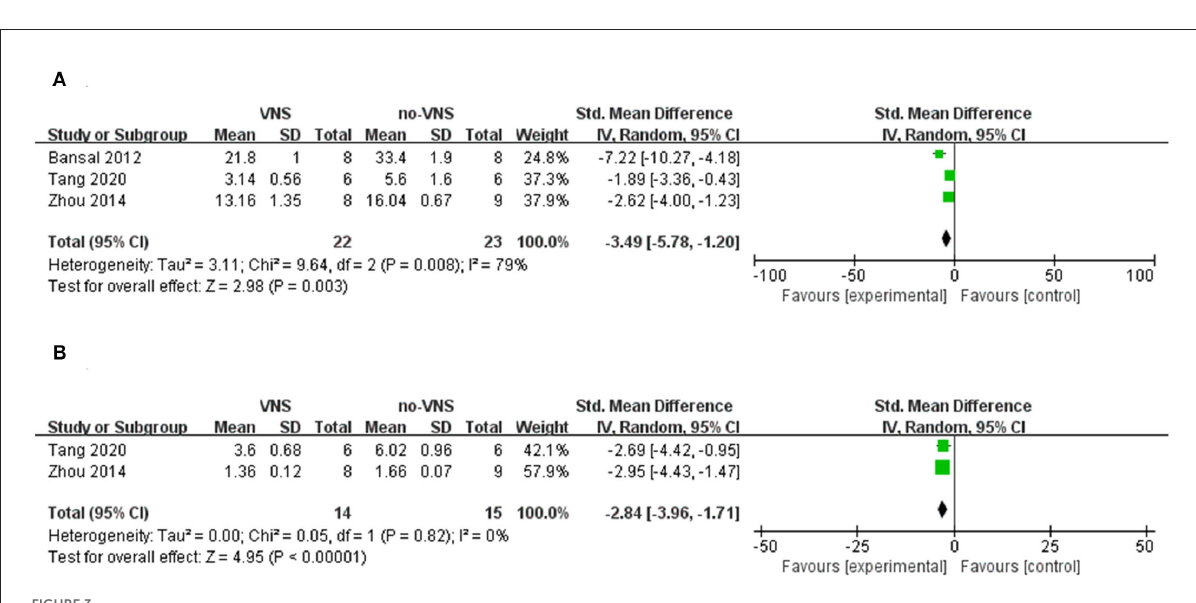
FIGURE3 Forest plot for comparison: VNS vs. no-VNS. TNF-a (A) , IL-1ß (B) .